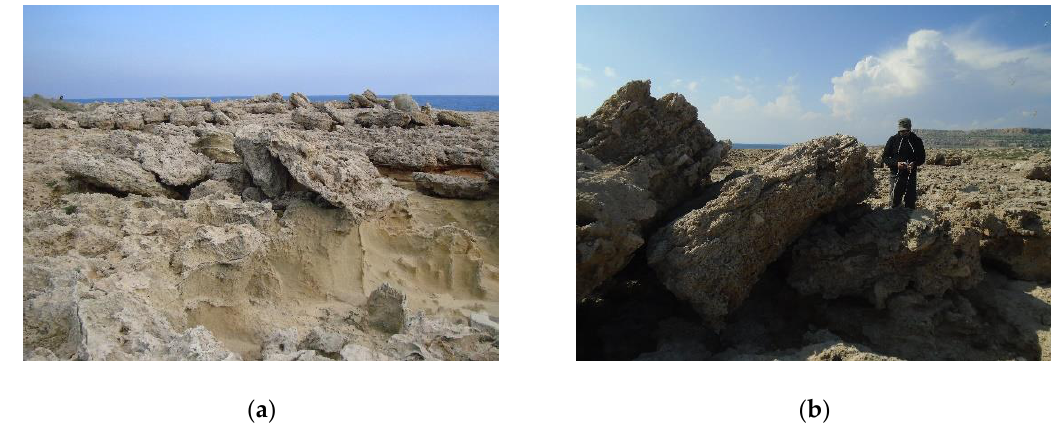
Figure 9. ( a ) Clusters of imbricated boulders on the eastern part of the study area; ( b ) a closer view of imbricated boulders. Table 2. Selected boulder measurements and storm wave height calculations based on different hydrodynamic equations [22–24,48,49]. All boulder measurements and calculations are provided in Table S1.